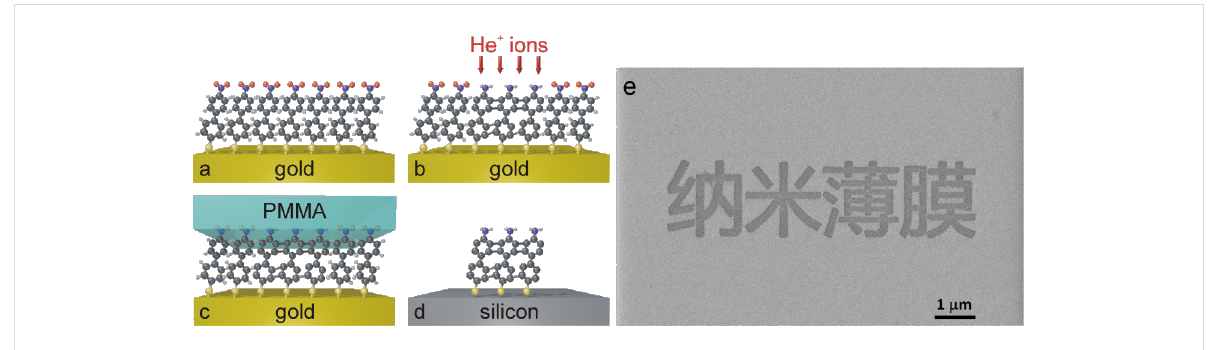
Figure 1: (a–d) A schematic representation of the NBPT SAM cross-linked with He + ions and the transfer onto a Si substrate: (a) Formation of SAM on Au; (b) Local exposure to He + ions; (c) Transfer of CNM with a polymeric film; (d) Separation of cross-linked from non-cross-linked regions. (e) A demonstration of lithographic CNMs in Chinese characters nanomembranes transferred on a silicon